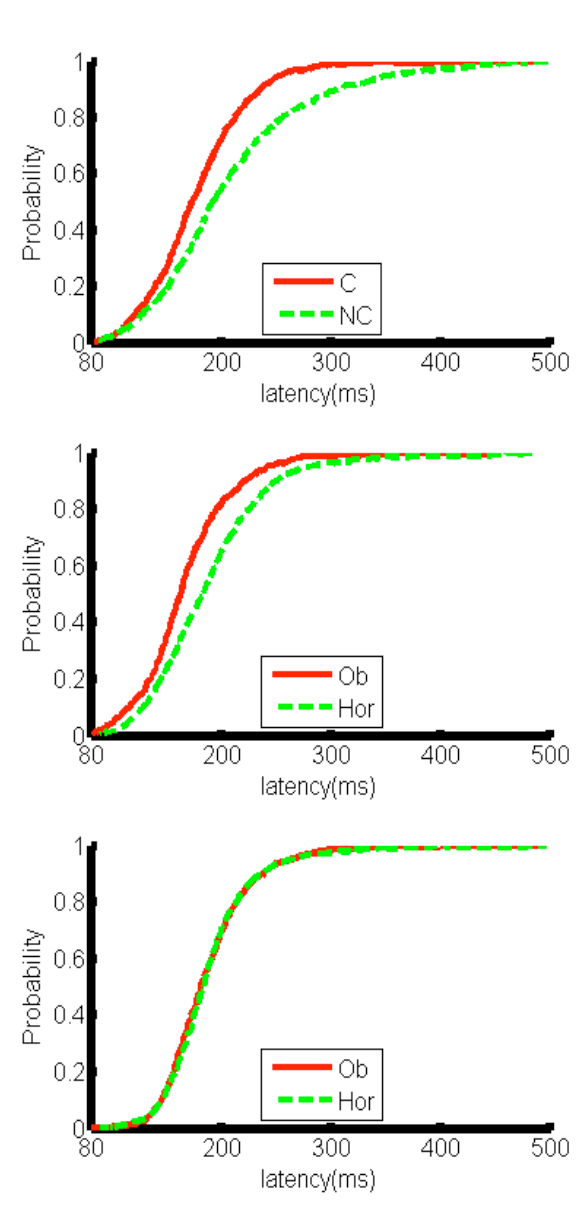
Figure 7. Latency distributions of the first catch-up sac- cade after